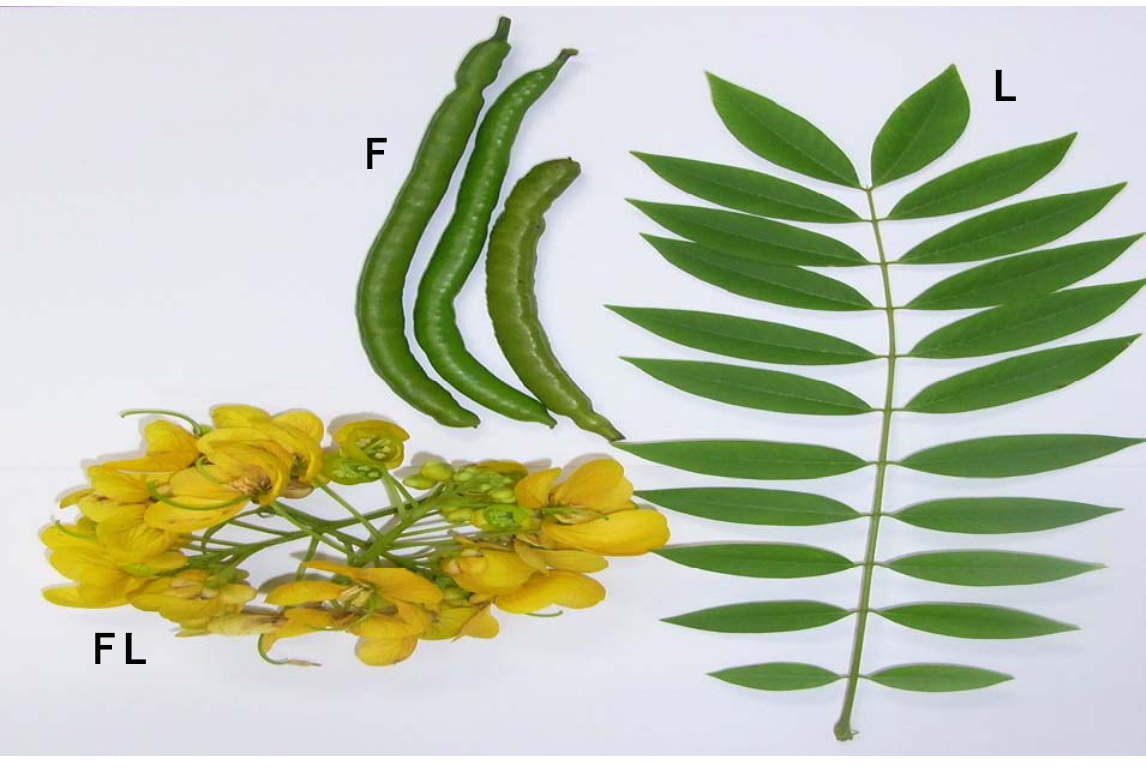
Figure 1. Cassia spectabilis. F, fruit; FL, flower and L,